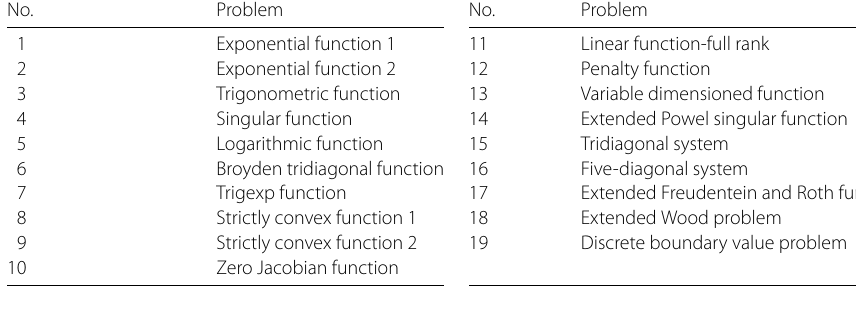
Figure 4 Performance profiles of these methods